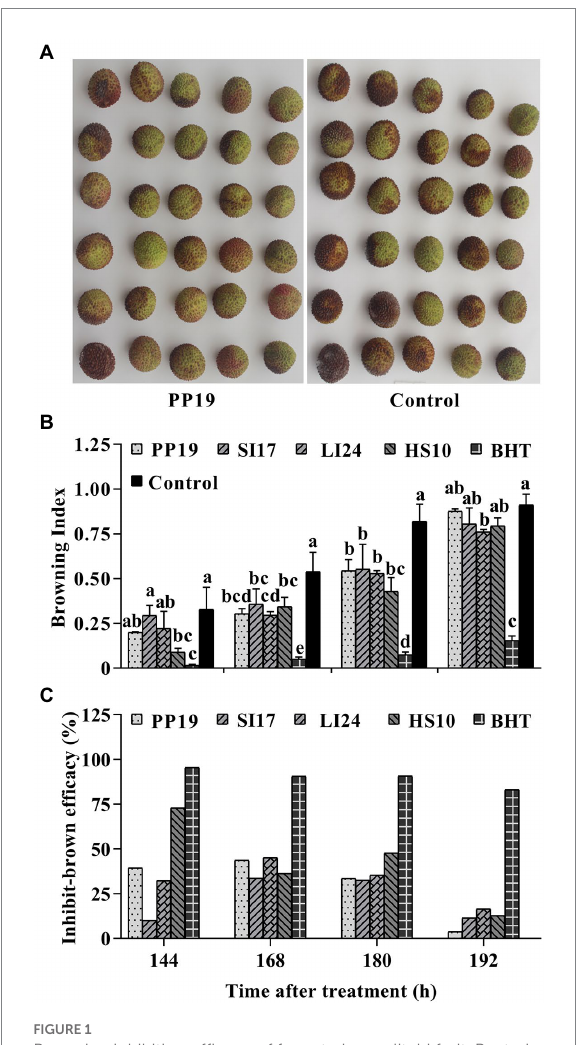
FIGURE 1 Browning inhibition efficacy of four strains on litchi fruit. Bacteria (5 × 10 7 CFUs mL − 1 ) were sprayed on cv. ‘Feizixiao’ (75–80% ripeness, Danzhou, Hainan province) in a laboratory. The images display a comparison of browning indices between the litchi fruit treated with PP19 and LB broth (Control) at 144 h (A) . Bar charts displaying the browning indices of harvested litchi fruit treated with the four strains PP19, SI17, LI24, and HS10, and the BHT and LB broth controls (B) . The browning inhibition efficacies are shown in panel (C) . Data are presented as means of replicates ± standard errors; different letters indicate significant differences between treatments according to LSD test at p <